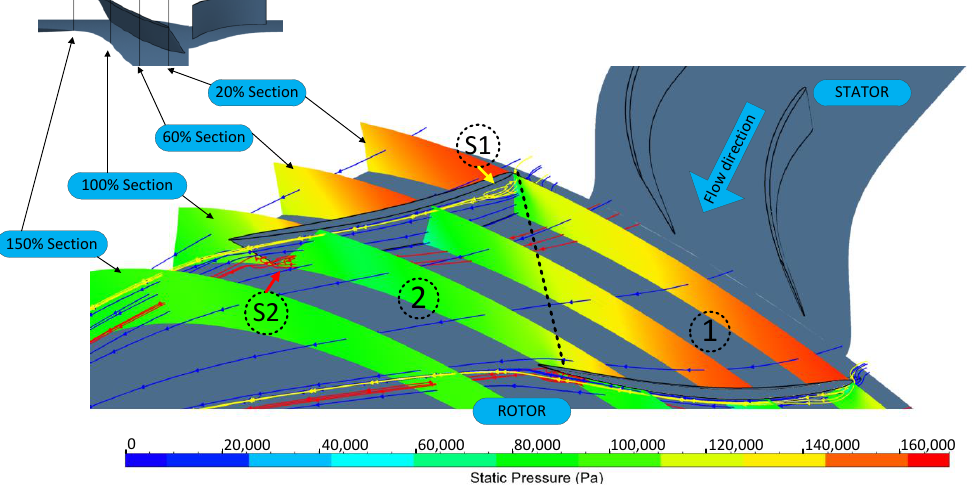
Figure 7. Static pressure contour of the cross stream of tip turbine at different sections.